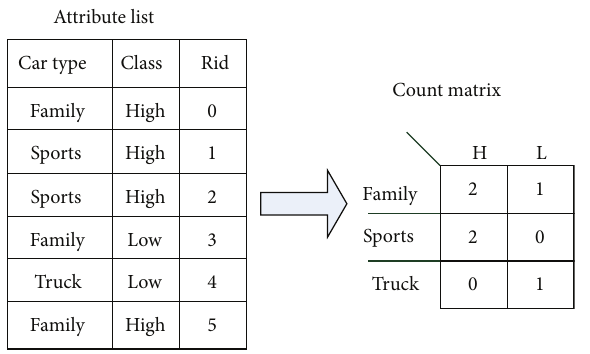
Figure 7: Flowchart of the proposed CUDT algorithm.